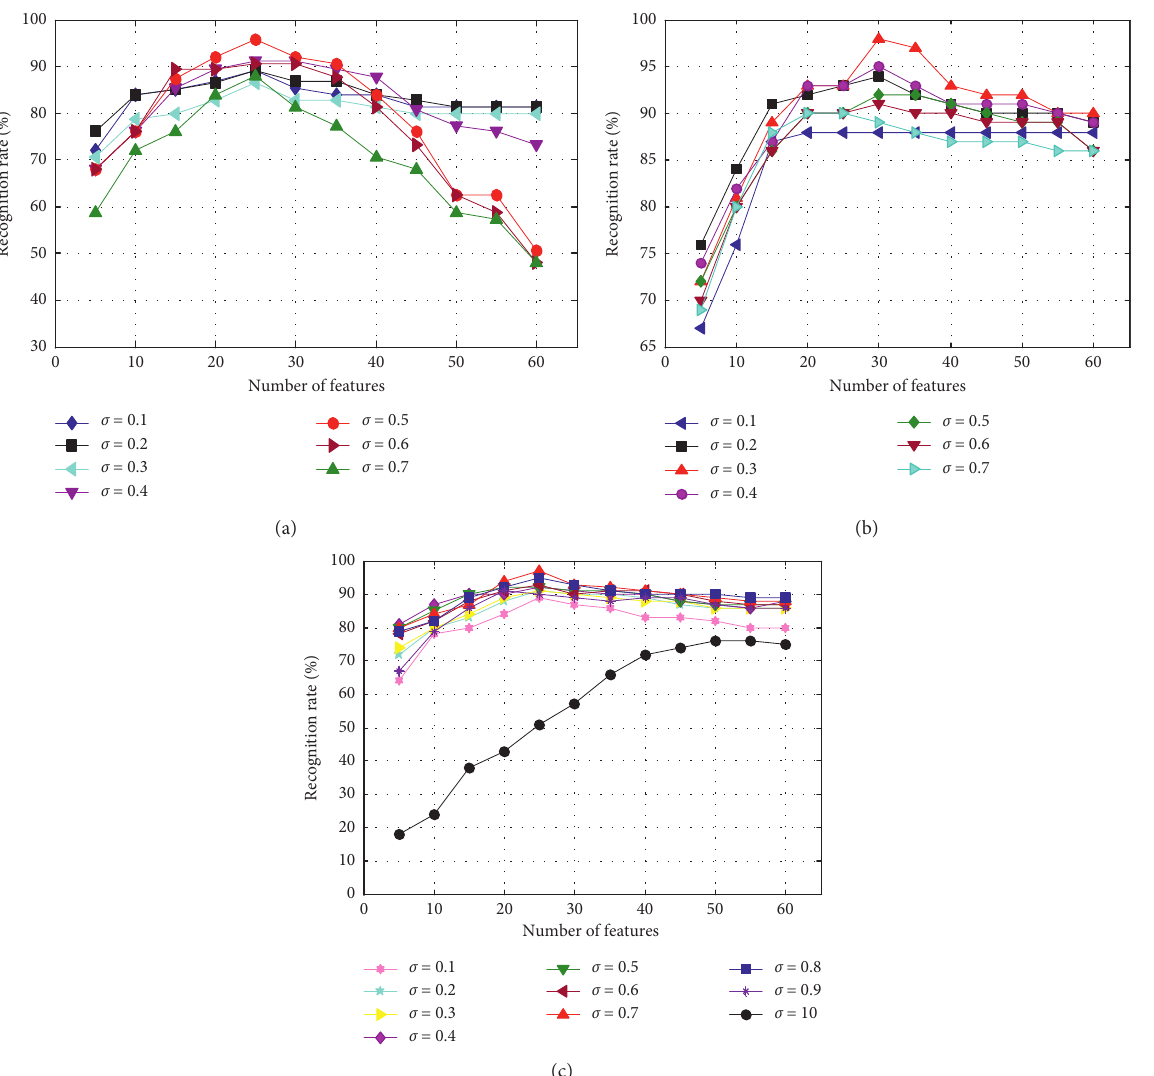
Figure 5: Recognition results based on different adjustable factor of kernel function and feature dimensions. (a) Experiment result based on Yale-B face database. (b) Experiment result based on ORL face database. (c) Experiment result based on UMIST face